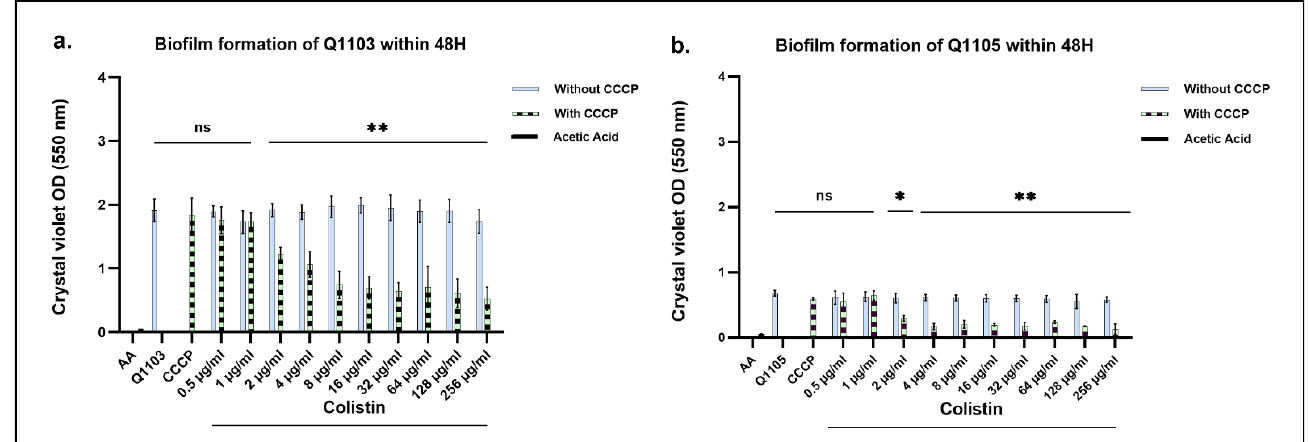
Figure 6. Effect of 10 µg/mL carbonyl cyanide 3-chloro phenyl hydrazone (CCCP) on biofilm formation in B. intermedia strains Q1103 and Q1105 after 48 h with and without colistin (CO). * and ** : p < 0.05; ns: non-significant.